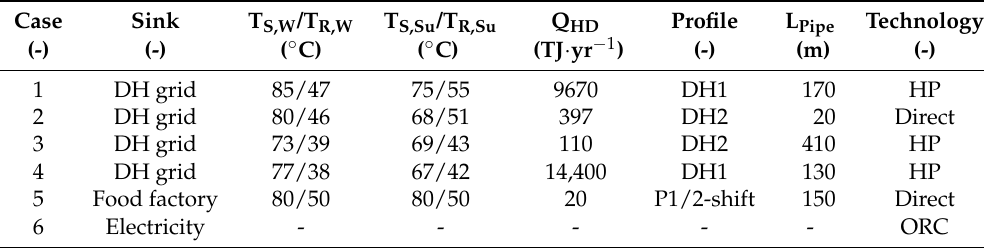
Table 6. Overview of the data used for the EH users as analyzed in the case